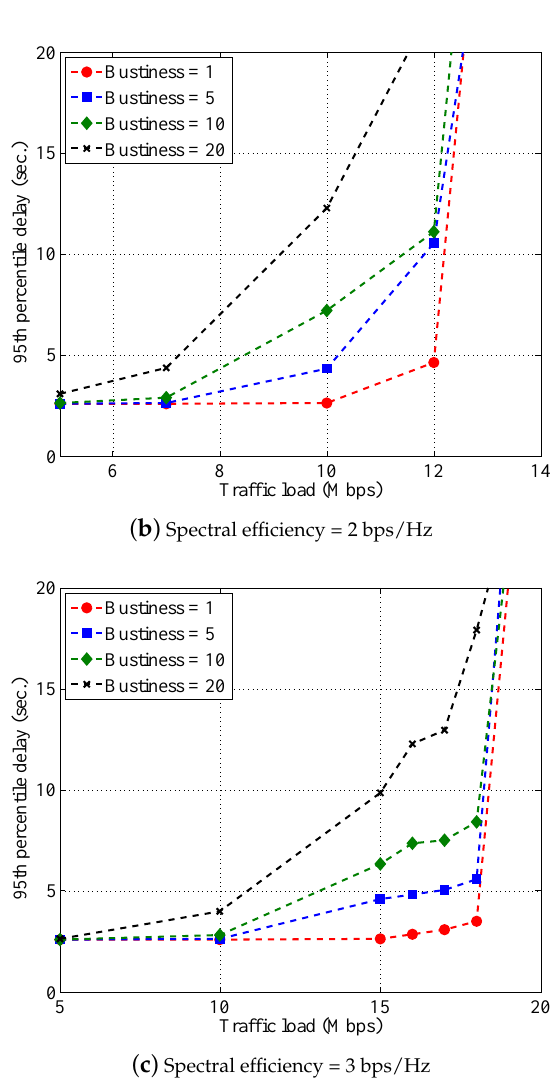
Figure 5. The 95th percentile delay according to the traffic load (Mbps) when burstiness varies from 1–20 (VBDC).